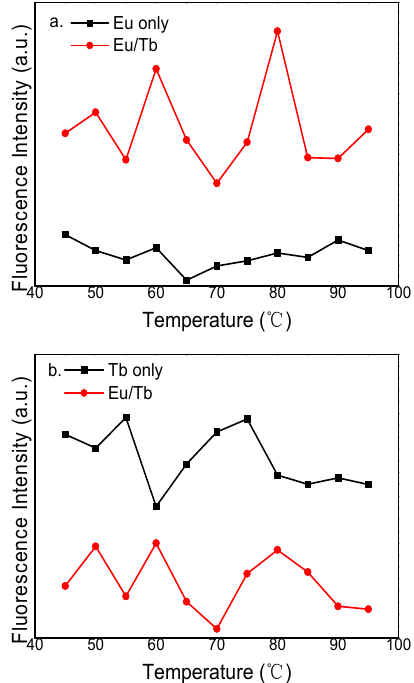
Figure 8. Fluorescence emission intensity of PVA fluorescent gel of ( a ) Eu and ( b ) Tb at different reaction temperatures.